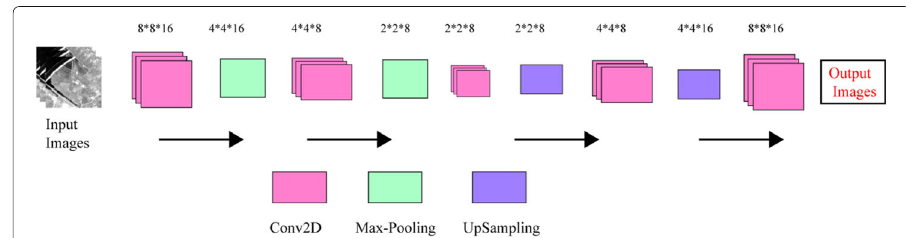
Fig. 2 The structure of the convolutional autoencoder